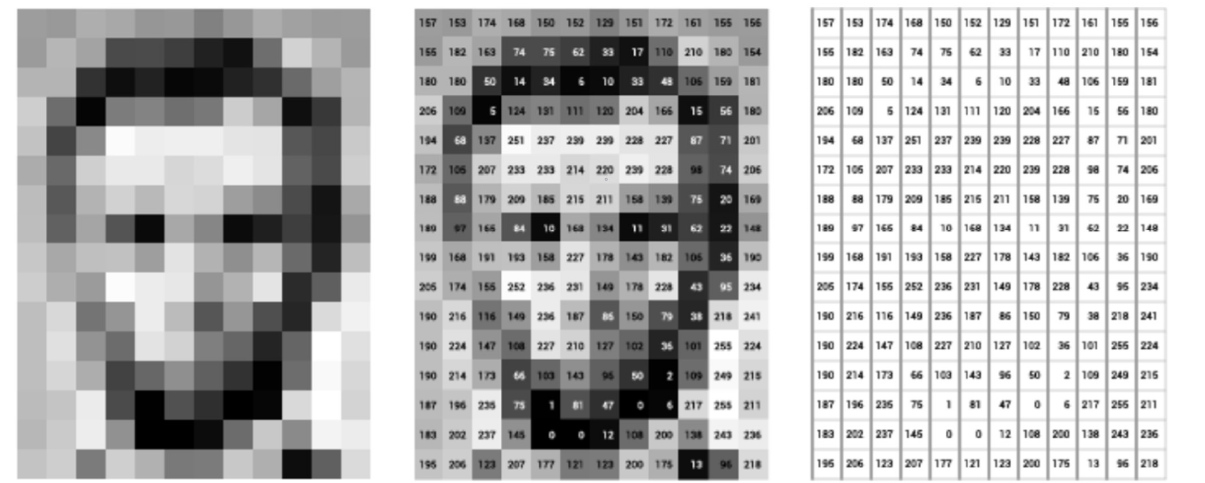
Figure 1. Digital image as matrix of numerical values. Numerical values represent pixel’s brightness in this example. Golan Levin. «Image Processing and Computer Vision», ofBook (work in progress). Available on: https://openframeworks.cc/ofBook/chapters/image_processing_computer_vision. html (accessed on 28 July 2022).